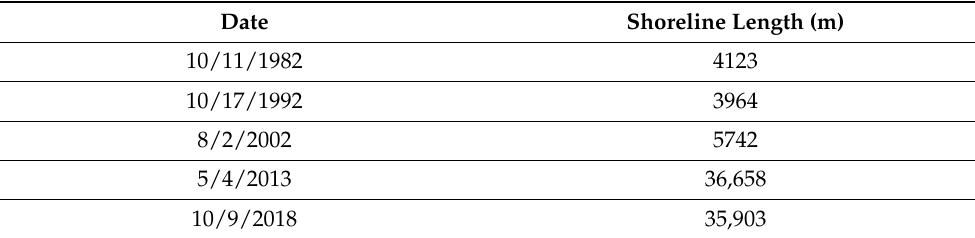
Table 5. Shoreline length data of Segment